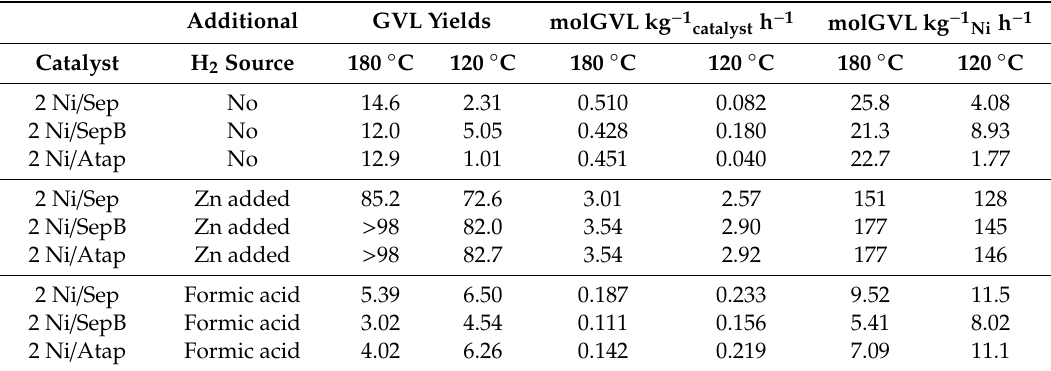
Table 3. Yield of LA into GVL (%) and productivity (mmol GVL / g catalyst / h and mmol GVL / g Ni / h) using Ni on di ff erent supports and hydrogen sources. a